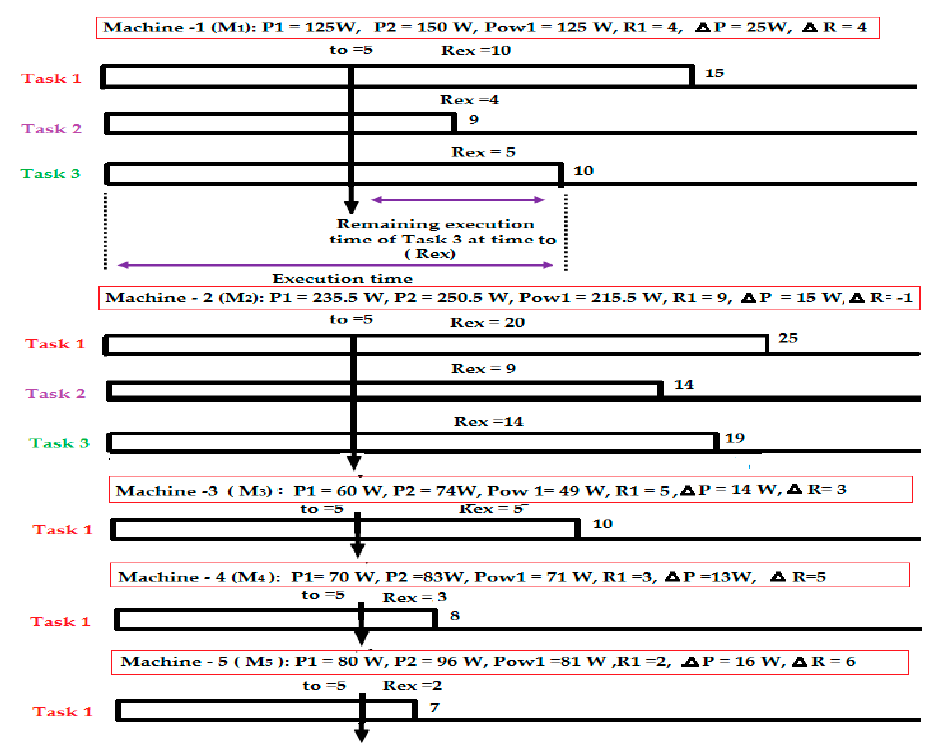
Figure 2. Host selection policy for carbon- and power-efficient optimal frequency(C-PEF).